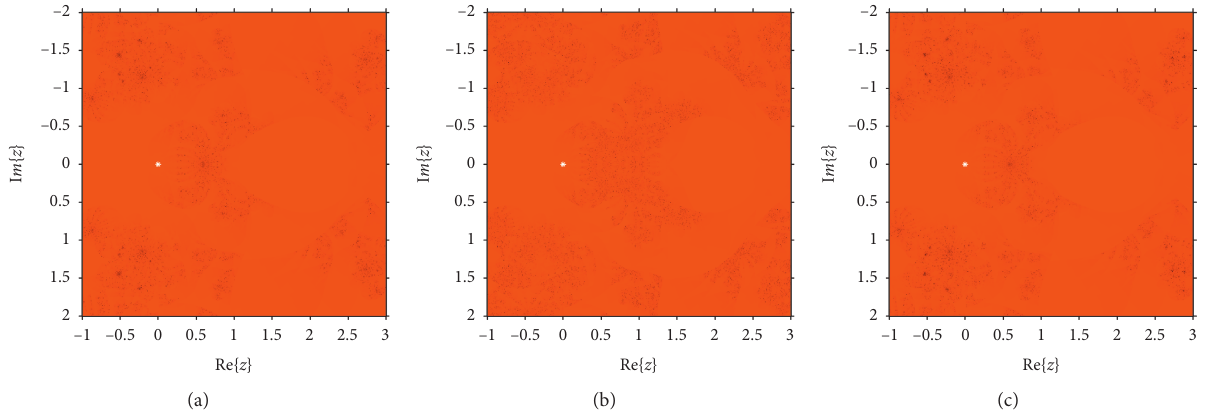
Figure 14: Basins of attraction of (a) SFM1, (b) SFM2, and (c) SFM3 for g